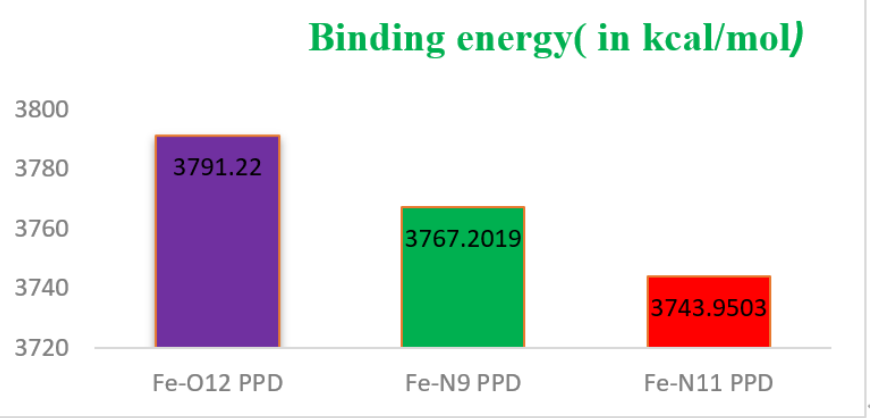
Figure 9. Binding energy or (interaction energy in absolute value) for Fe−X j (PPD) in different active (Xj: O 12 , N 9 and N 11 ) centers.